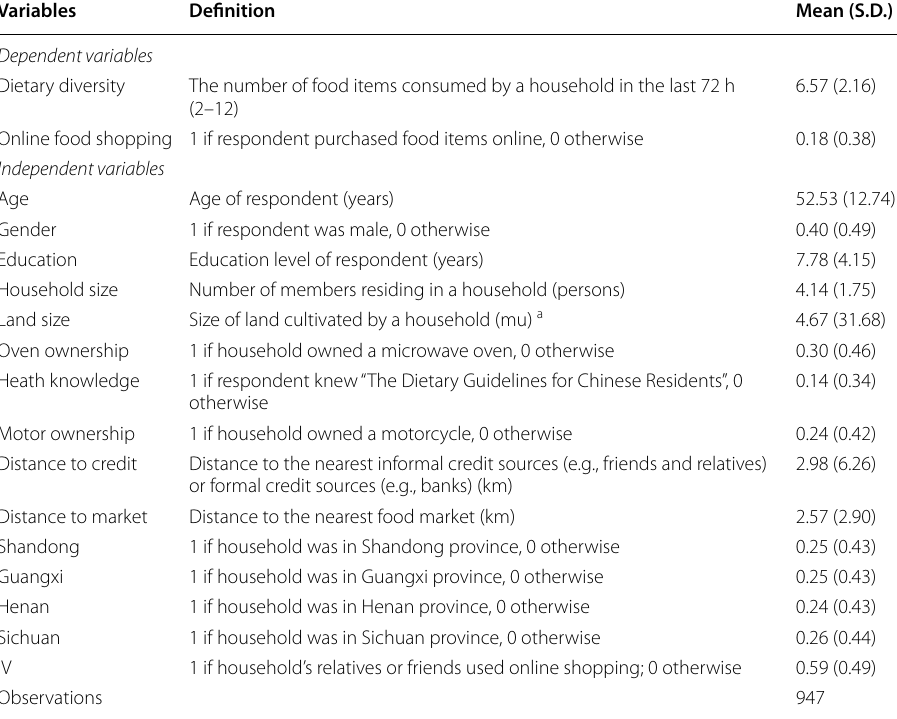
Table 1 Variable definitions and summary statistics